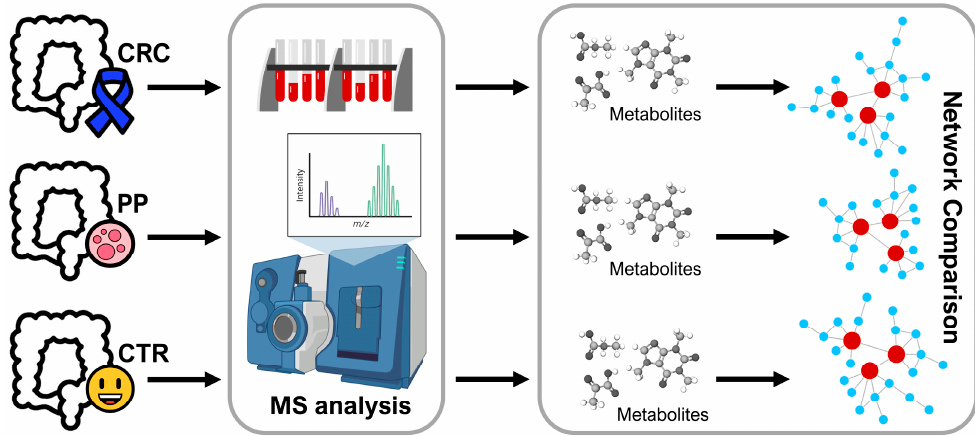
Figure 1. Study design of our study on colorectal cancer (CRC) patients, polyposis (PP) patients and healthy controls (CTR). healthy controls